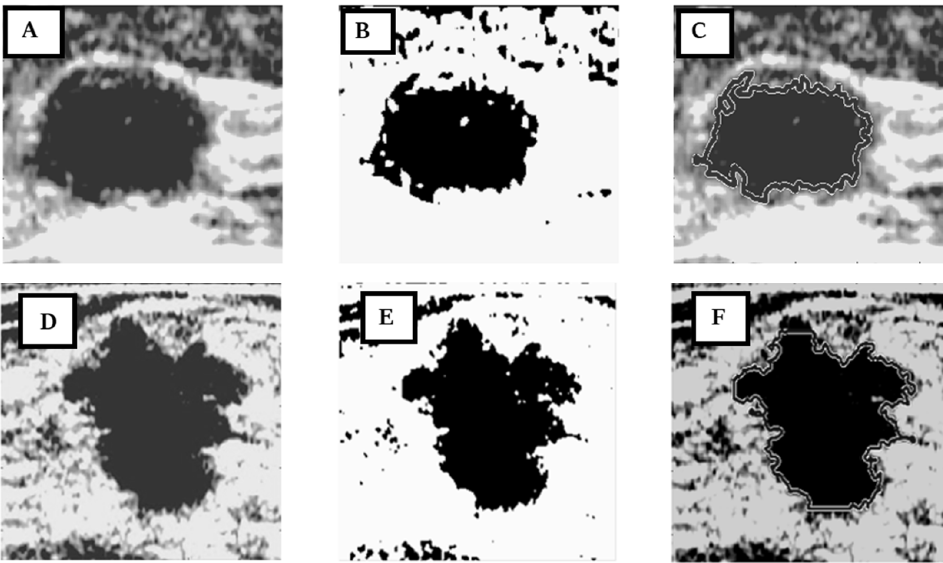
Figure 2. Example of binarization and ROI segmentation where the first row is the benign case, and the second row is the malignant case. ( A , D ) Normalized B-mode US images; ( B , E ) binary images, and ( C , F ) lesion boundary outlined automat-